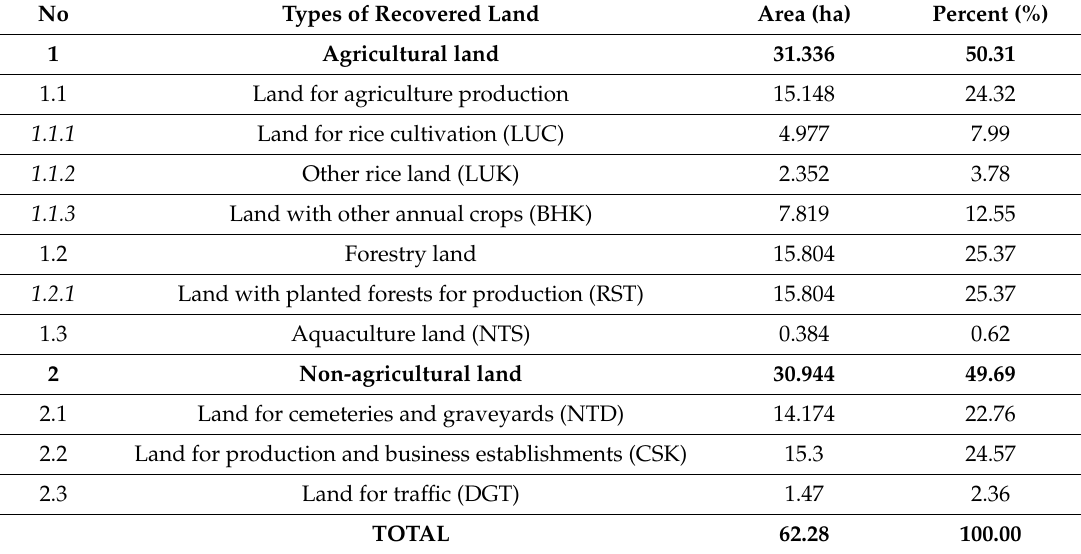
Figure 1. Location of Quang Ninh district and the project. Source: Tran Tuan NGUYEN. Table 1. The information on land acquisition for the project of Northwest Quan Hau Industrial Park (until December, 2017).